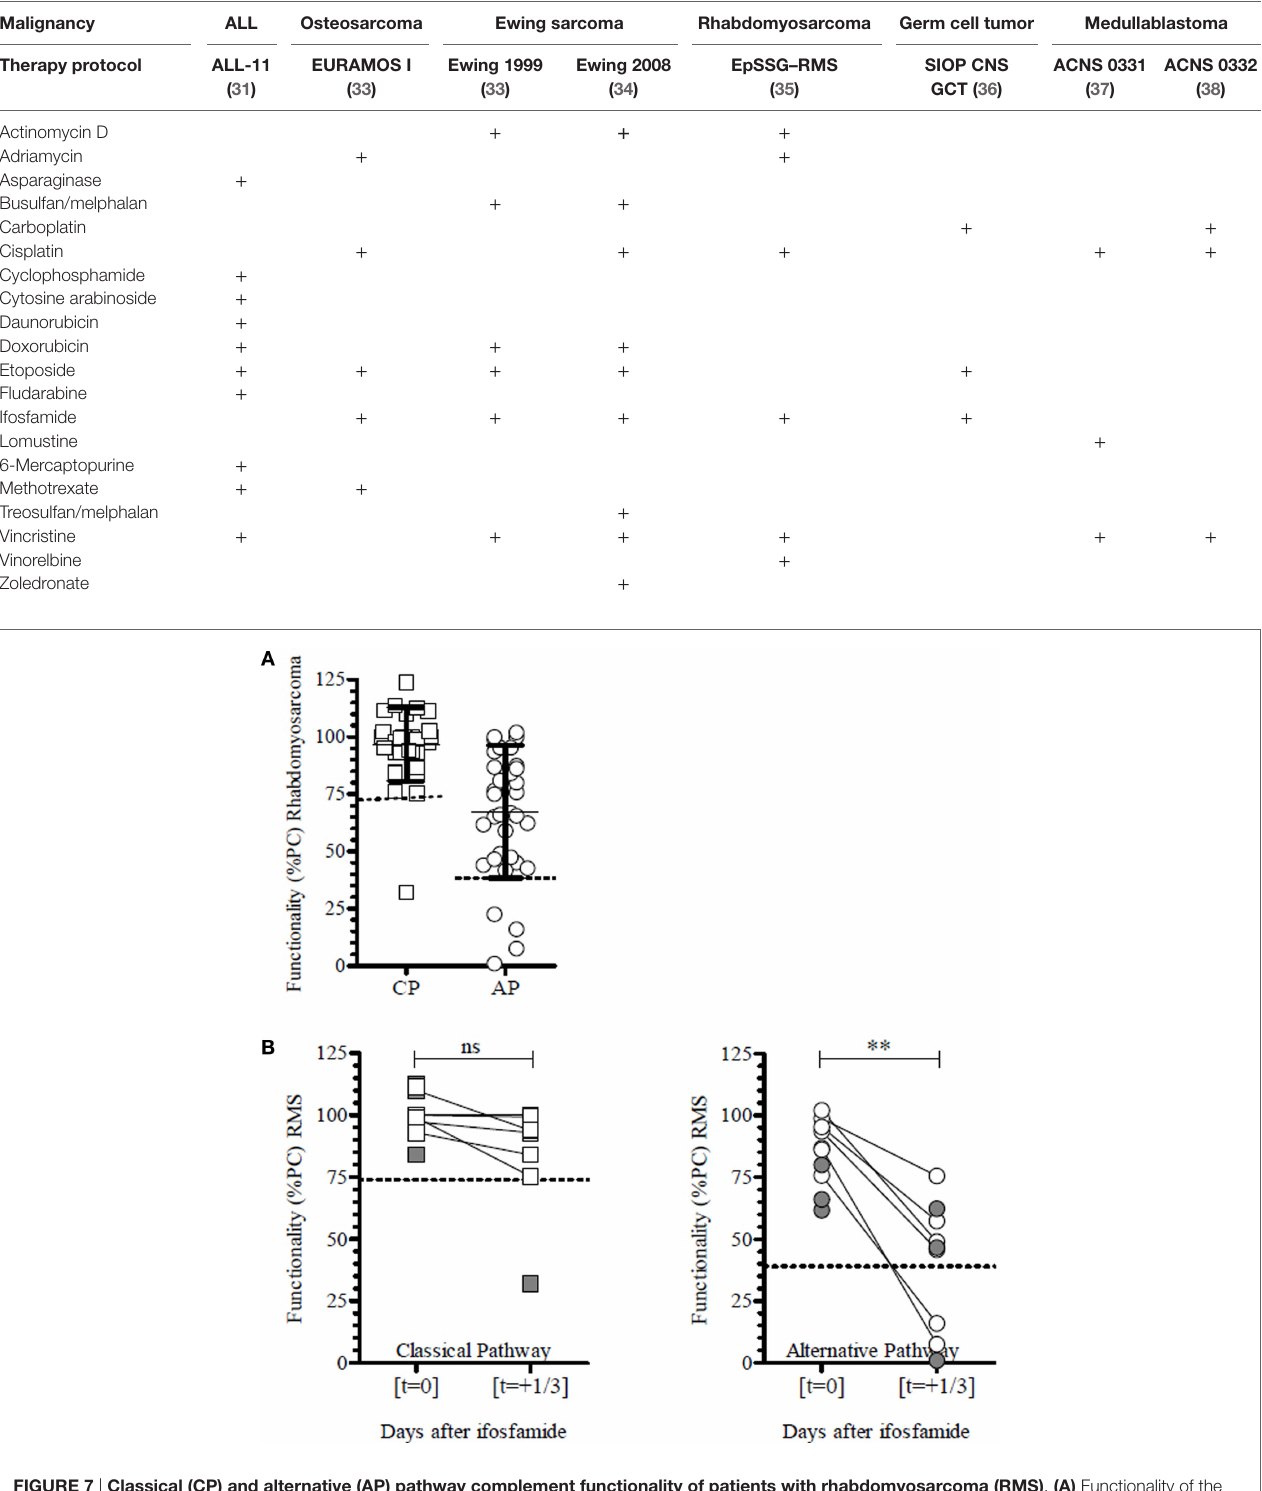
TaBle 3 | Overview of the most commonly used chemotherapeutic compounds in the different treatment